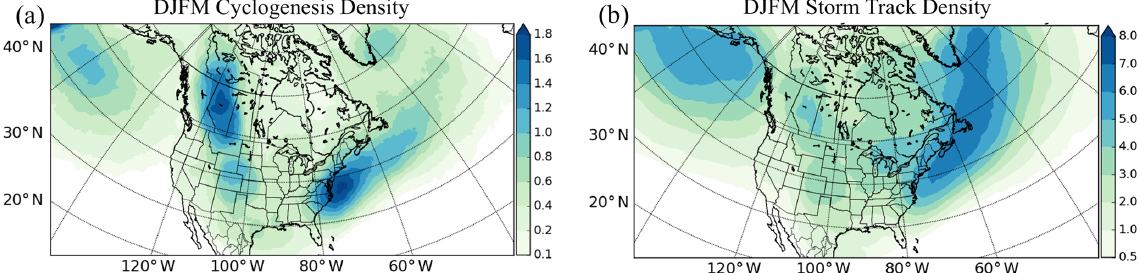
Figure 3. ERA5 average cool-season (December to March) (a) cyclogenesis density and (b) storm track density over the 1979–2018 period. The units are number of cyclones per month per area of 1000km 2